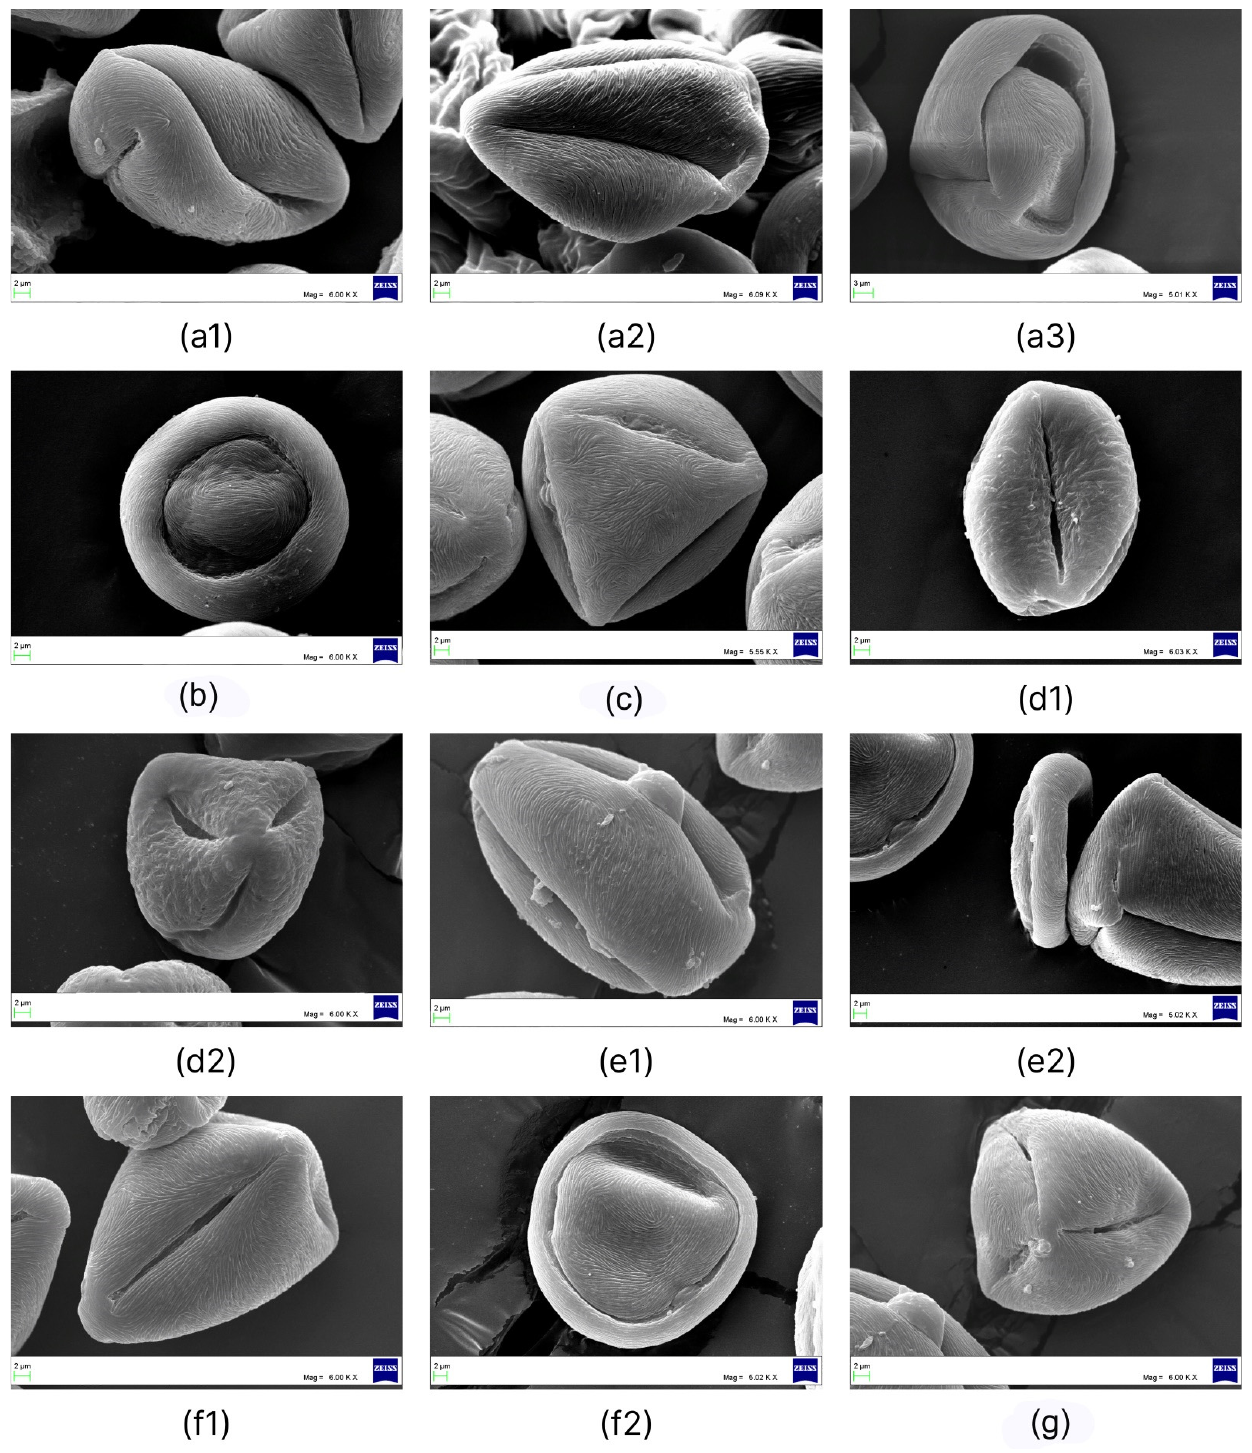
Figure 6. Deformed pollen grains of N. schoberi from ( a1 – a3 ) Kulunda, ( b ) Malinovoe, ( c ) Karatal, ( d1 , d2 ) Basshi, ( e1 , e2 ) Sariozek, ( f1 , f2 ) Taskarasu, and ( g ) Balhash.